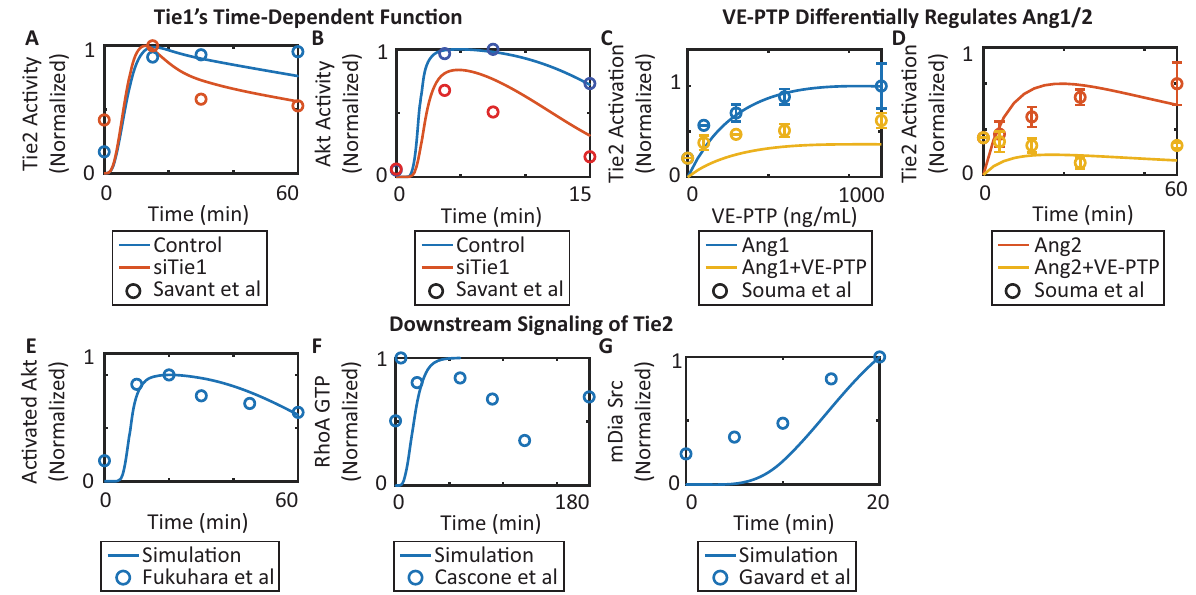
Fig. 3 Model calibration of molecular regulatory mechanisms of downstream signaling of the Ang – Tie pathway. A Tie1 silencing acutely inhibits but chronically sustains Tie2 activation (Savant et al. 33 ). B Tie1 silencing inhibits Akt activation (Savant et al. 33 ). C , D VE-PTP differentially regulates Ang1- and Ang2-activated Tie2 (Souma et al. 17 ). E – G Ang1 activates Tie2 and its downstream signaling including activation of Akt, RhoA-GTP, and Src sequestration by mDia (Cascone et al. 42 , Fukuhara et al. 38 , Gavard et al. 41